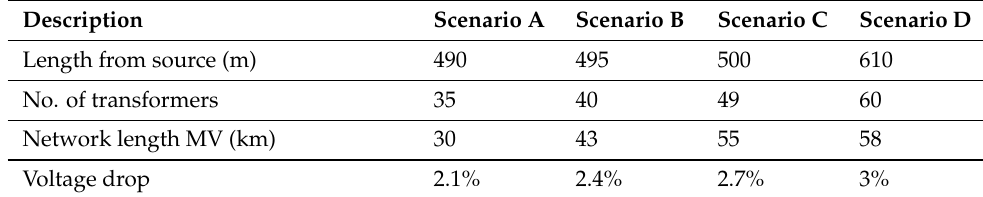
Table 7. Near-optimal solution for each case study.